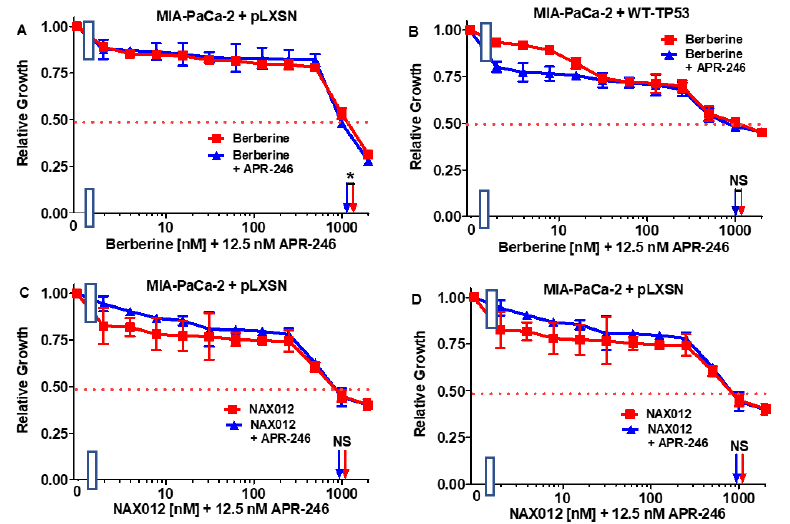
Figure 3. APR-246 does not enhance the responses of berberine or NAX012 to MIA-PaCa-2 cells containing or lacking WT-TP53 protein. Panel ( A ) MIA-PaCa-2 + pLXSN cells treated with different concentrations of BBR (red squares) or with different concentrations of BBR and a low dose of APR-246 (blue triangles). Panel ( B ) MIA-PaCa-2 + WT-TP53 cells treated with different concentration of BBR (red squares) or with different concentrations of BBR and a low dose of APR-246 (blue triangles). Panel ( C ) MIA-PaCa-2 + pLXSN cells treated with different concentrations of NAX012 (red squares) with different concentrations of NAX012 and a low dose of APR-246 (blue triangles). Panel ( D ) MIA-PaCa-2 + WT-TP53 cells treated with different concentration of NAX012 (red squares) or with different concentrations of NAX012 and a low dose of APR-246 (blue triangles). These experiments were repeated 4 times, and similar results were observed. * = p < 0.05, NS, not statistically significant.